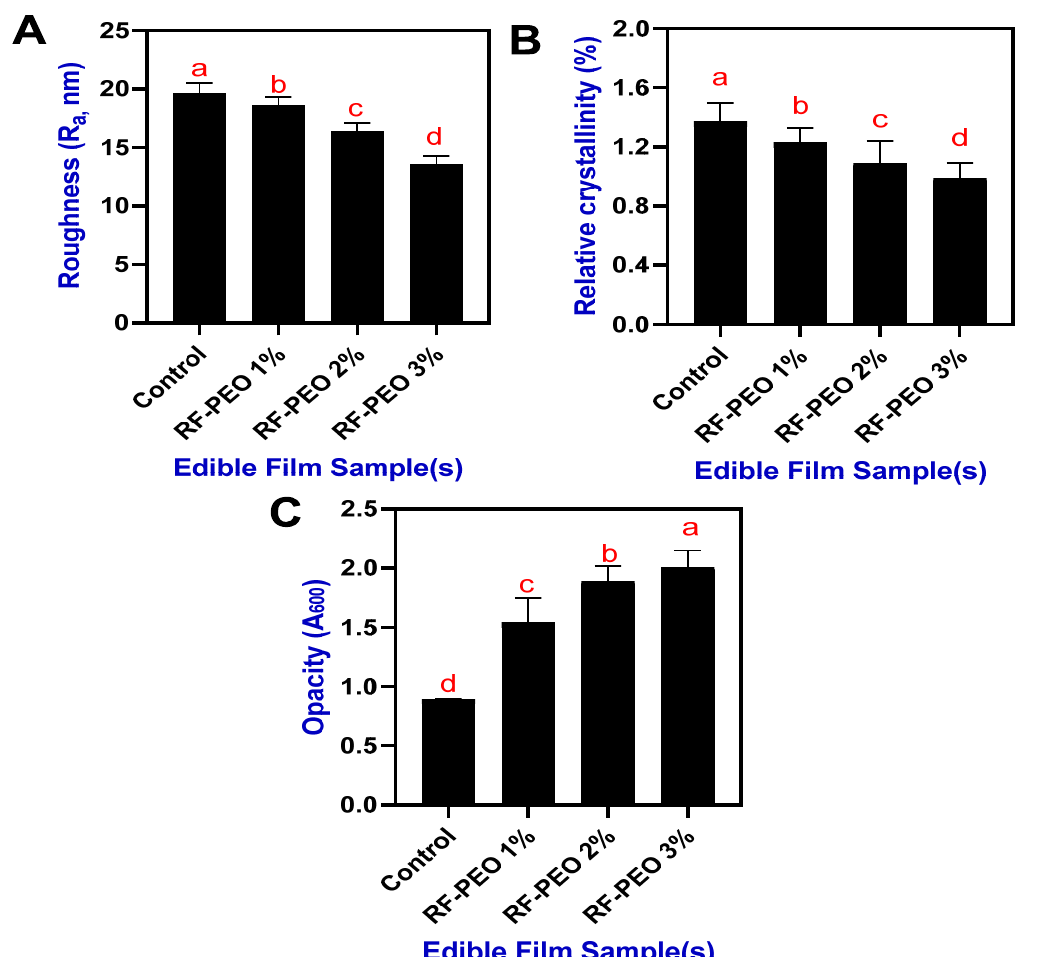
Figure 3. Roughness ( A ), relative crystallinity ( B ), and opacity ( C ) of edible films composed of RF-PEO at varying concentrations. The different letters of the alphabet shown on the bar diagram indicate significant di ff erences.